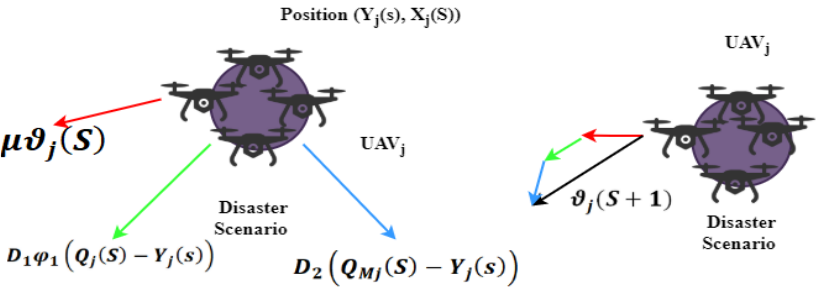
Figure 3. Disaster position analysis.